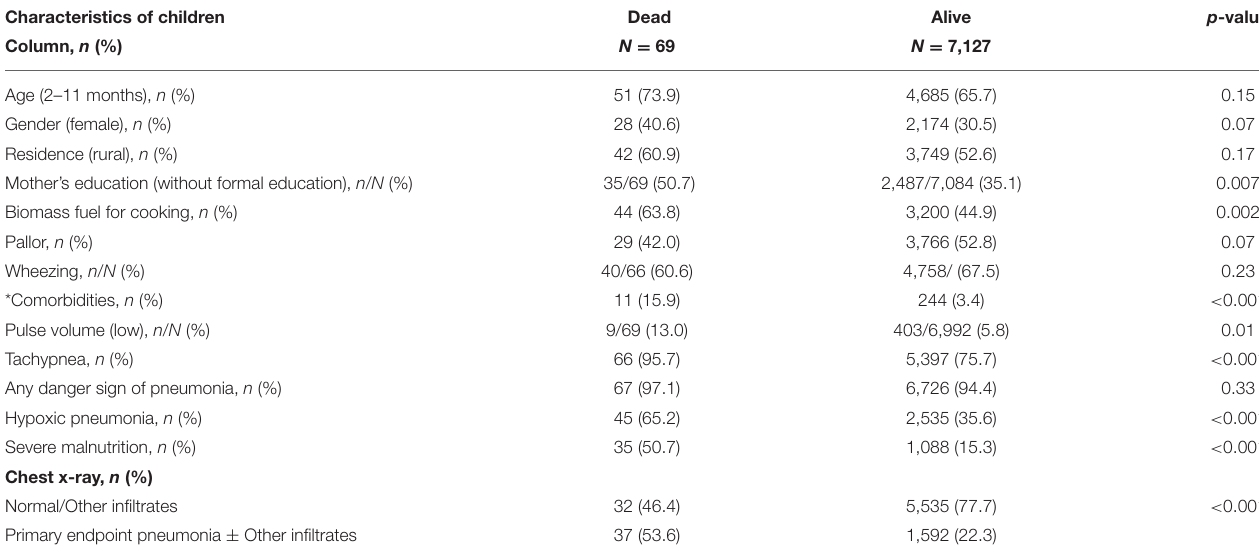
TABLE 3 | Comparison of sociodemographic and clinical variables of cases with and without adverse outcome (death). Characteristics of children Dead